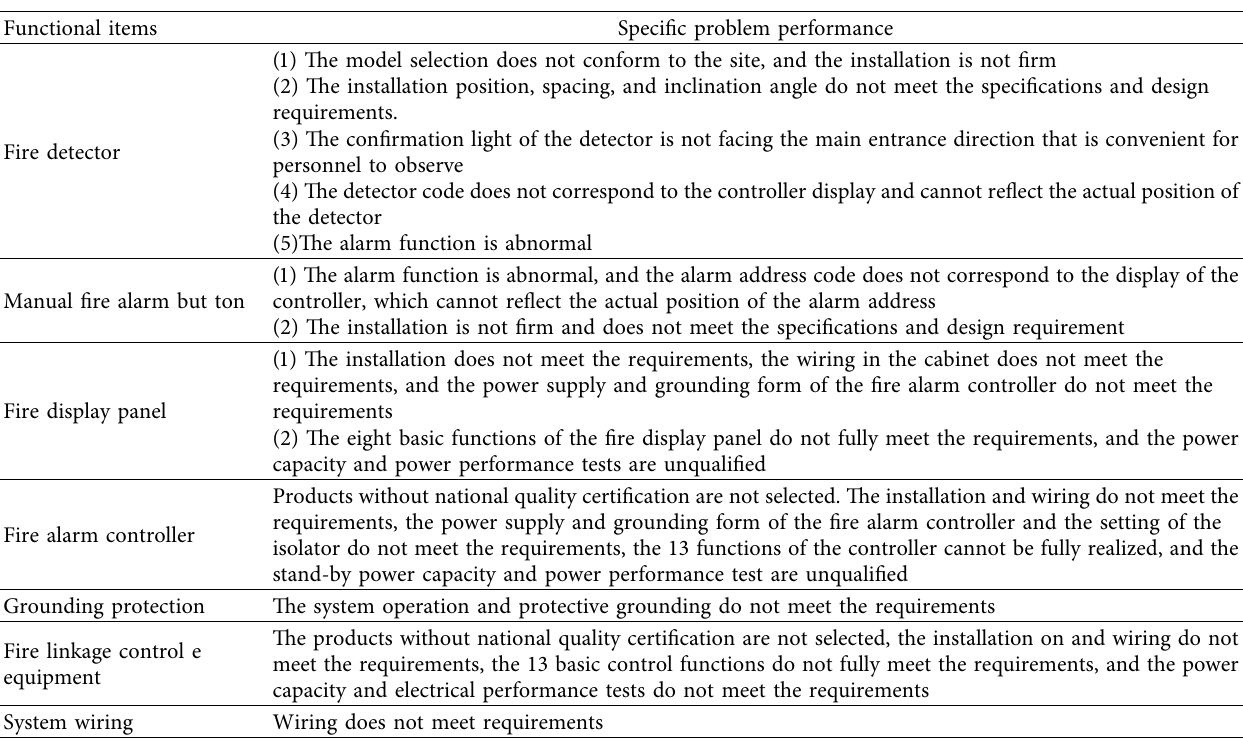
Table 7: Te problem of automatic fre alarm systems (source: author).